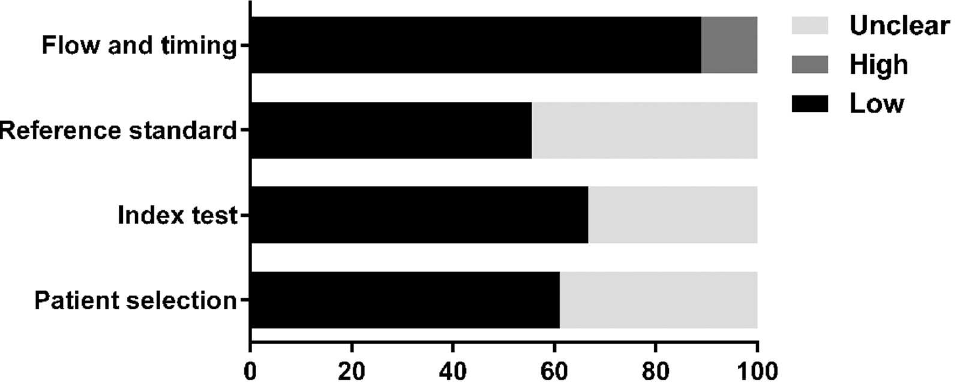
Fig 2. Proportion of studies with low, high, or unclear risk of bias,